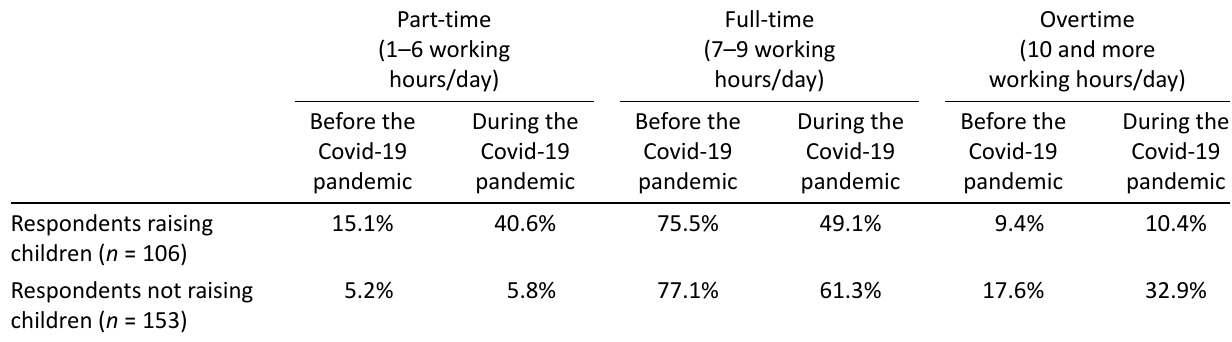
Table 4. Working hours per day of respondents raising children and respondents not raising children before and during the